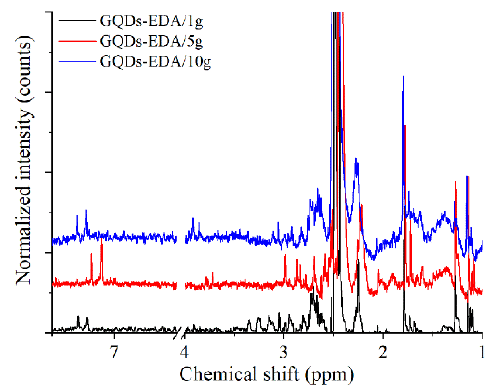
Figure 6. 1 H NMR spectra of GQDs-EDA/1 g (black), GQDs-EDA/5 g (red), and GQDs-EDA/10 g (blue).